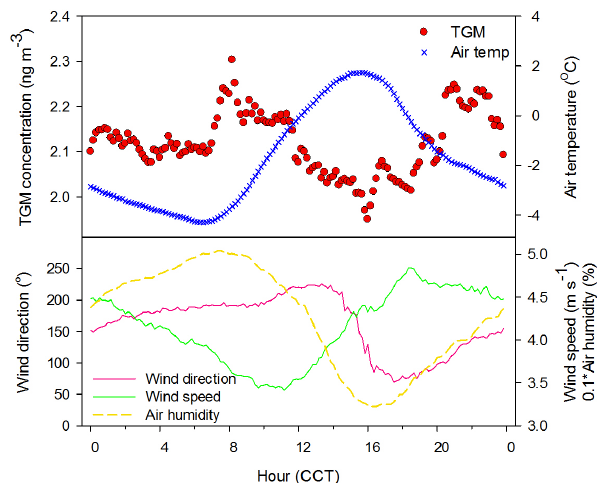
Fig. 10. Diurnal variation of TGM concentration in ambient air and meteorological parameters at WLG during the whole study period.